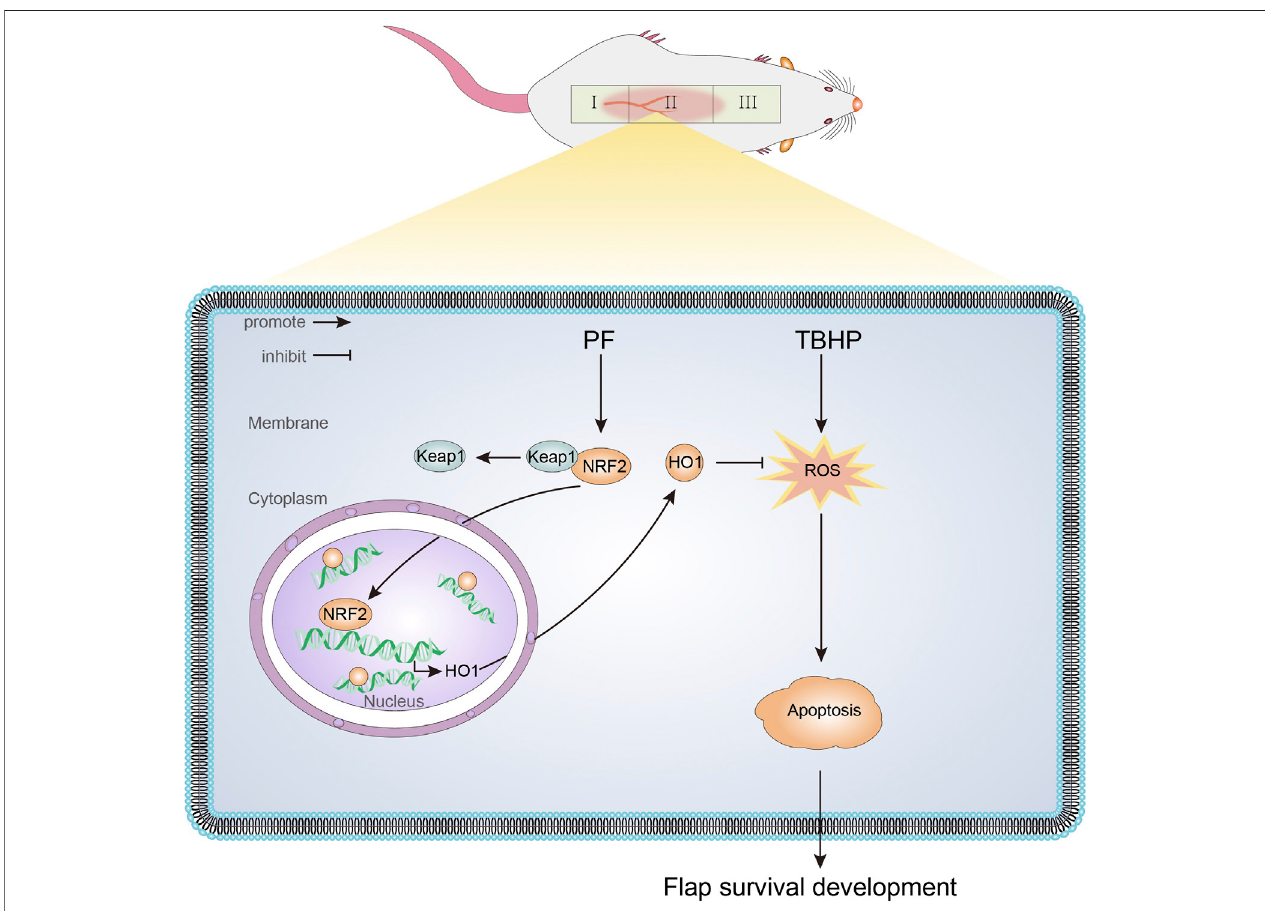
FIGURE 9 | A schematic diagram illustrating the role of PF in protecting against oxidative stress via the Nrf2/HO-1 signaling pathway.